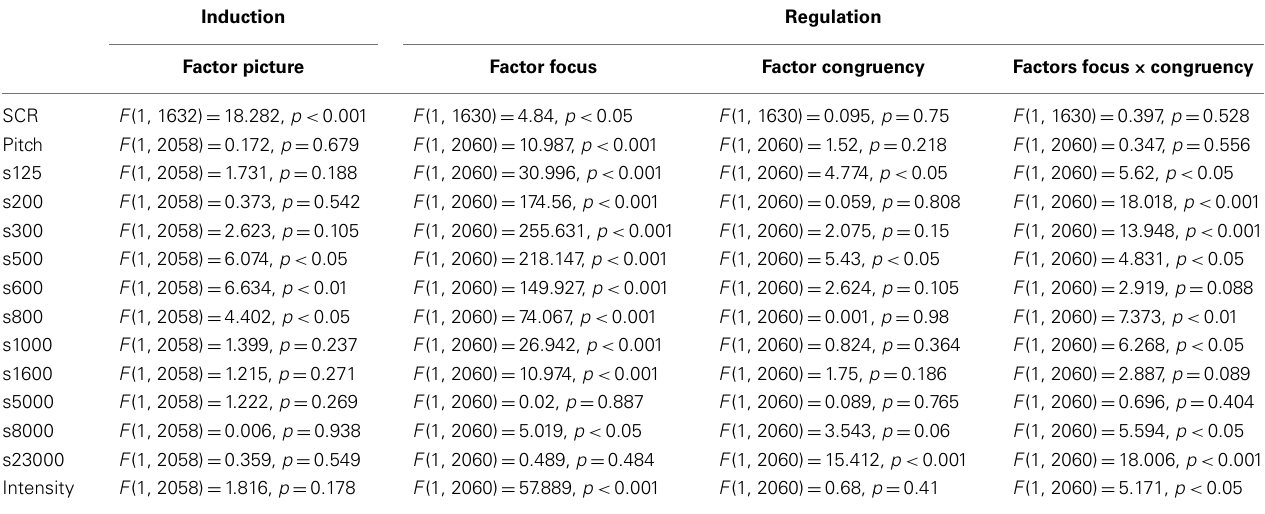
Table 4 | Results from the random-intercept models of the voice analysis ( F